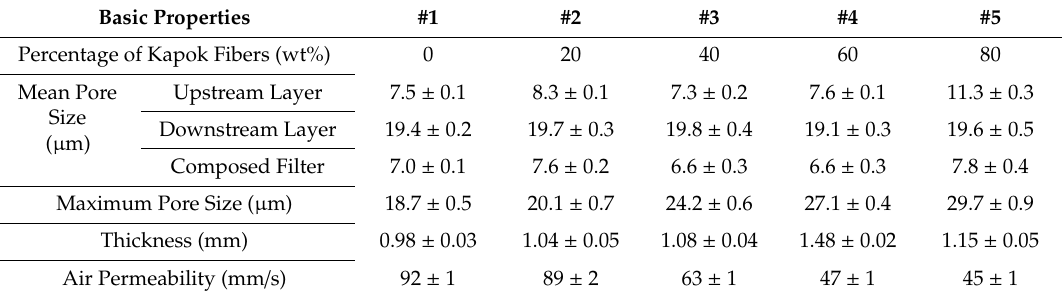
Figure 5. The diagram of coalescence of filter media prepared by hydrophilic / hydrophobic fibers. Table 3. The basic properties of filter media with different content of kapok fibers.